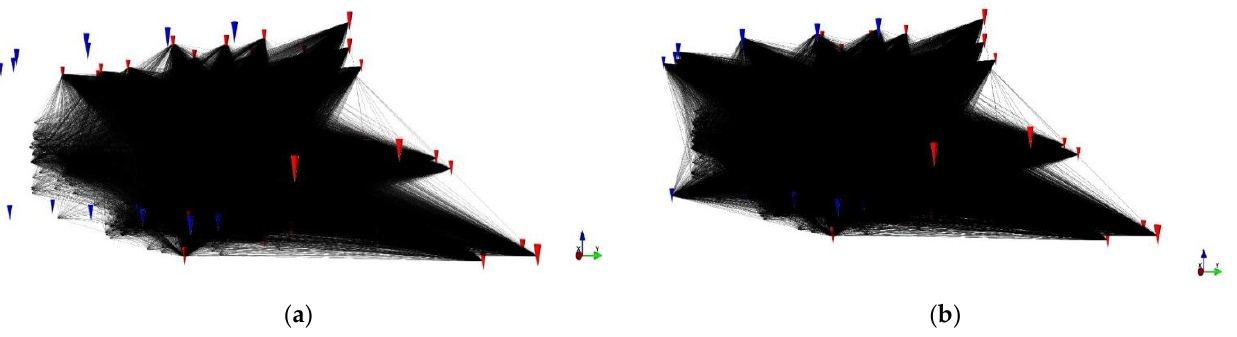
Figure 6. ( a ) Raypath following the facility (red triangles). ( b ) Raypath in the off-facilities area (blue